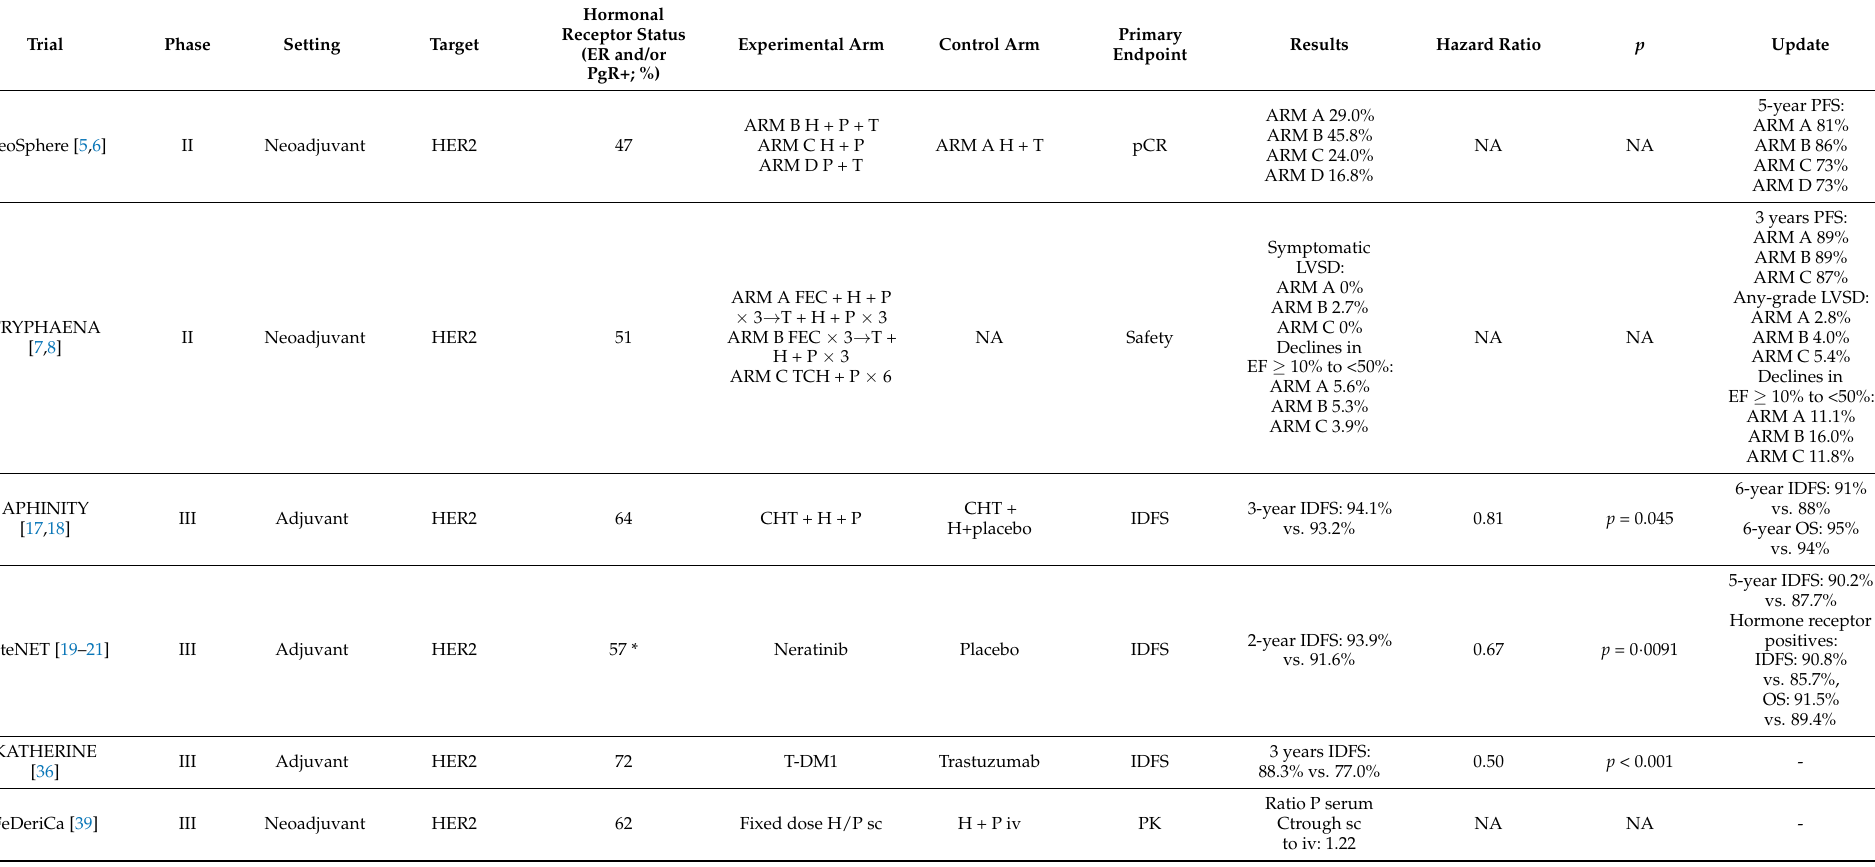
Table 2. Results of clinical trials (first analysis and update) leading to approval for the treatment of localized/locally advanced breast